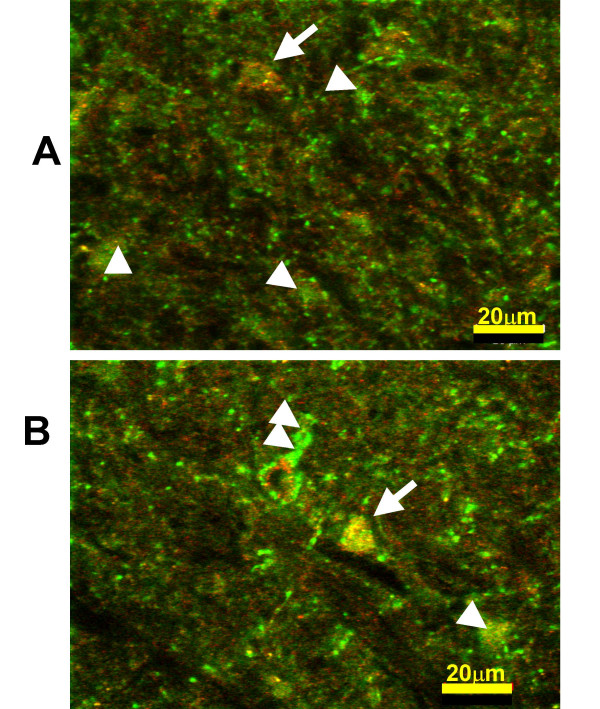
Confocal microscopy of cryosection of inferior colliculus slices stained with anti glutamic acid decarboxylase (green) and anti μ-opioid receptor antibodies (red). A : Central nucleus of inferior colliculus. B: Pericentral nucleus of inferior colliculus. Arrow head: example of GABAergic neurons not containing μ-opioid receptor (Green). Arrows: example of GABAergic neuron containing μ-opioid receptor (Yellow).